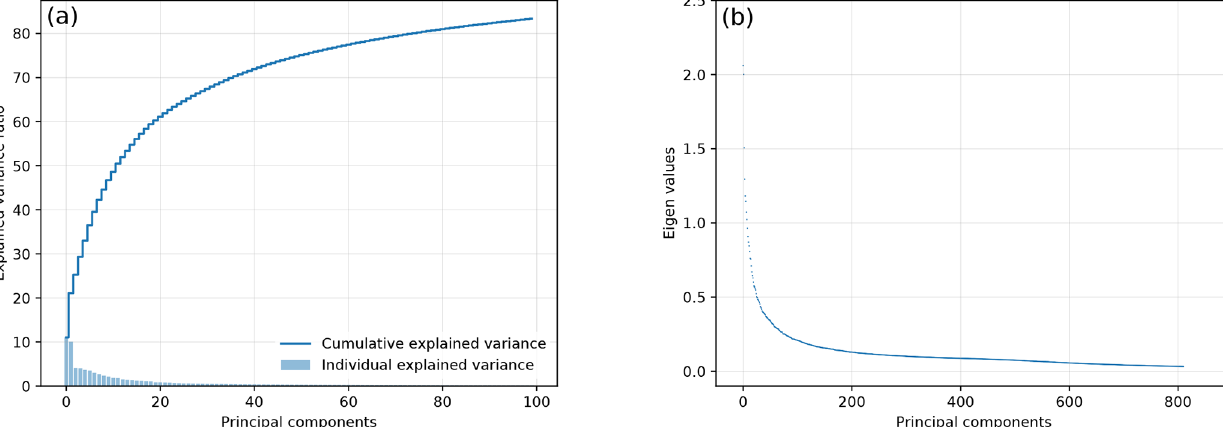
Figure 4. The cumulative percentage variance explained (a) and the eigenvalues (b) in the prior error covariance